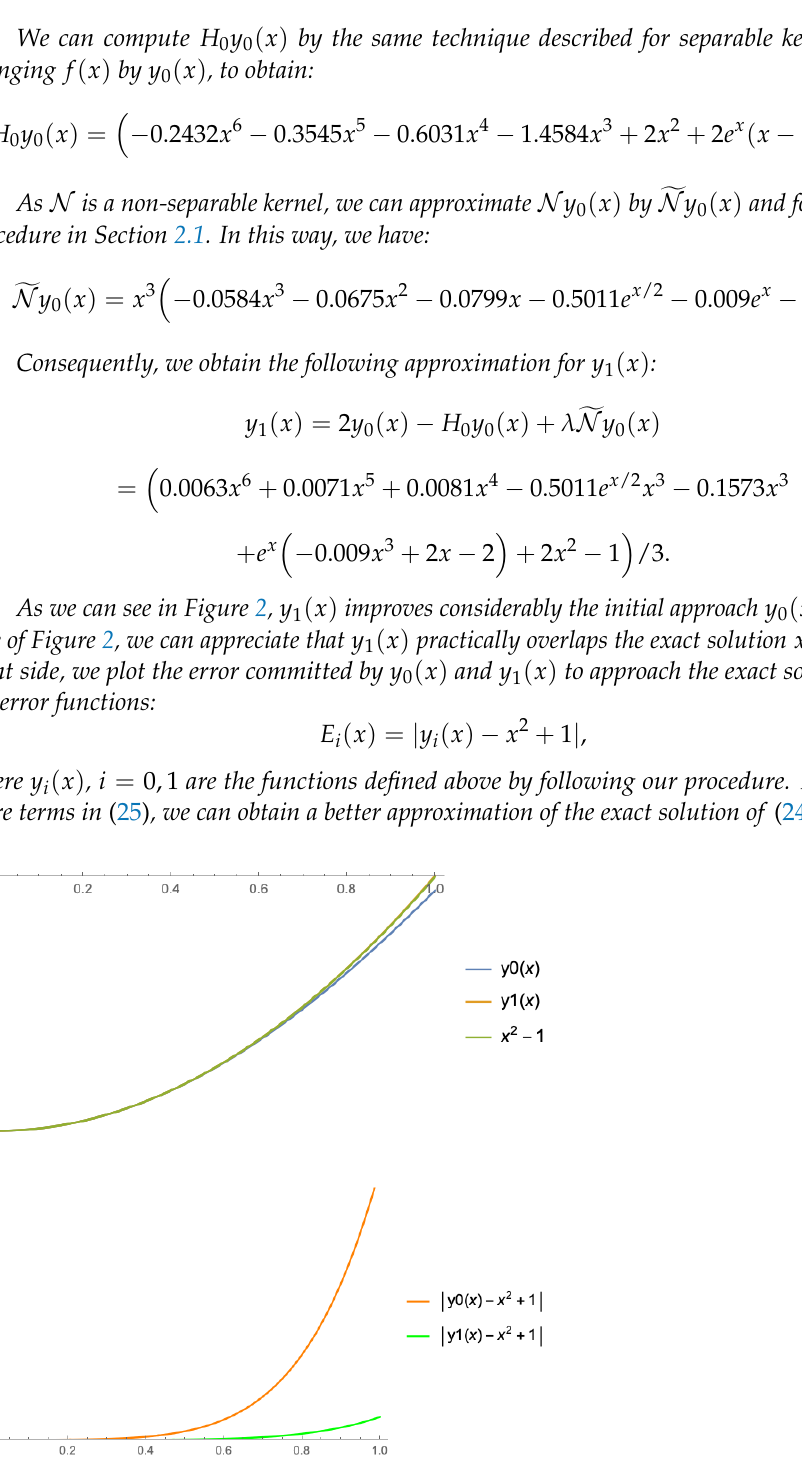
Figure 2. On the left, the graphics of the first two approximations to the solution of the integral Equation (24) and the exact solution y ( x ) = x 2 − 1. On the right, the graphics of the corresponding errors E i ( x ) defined in